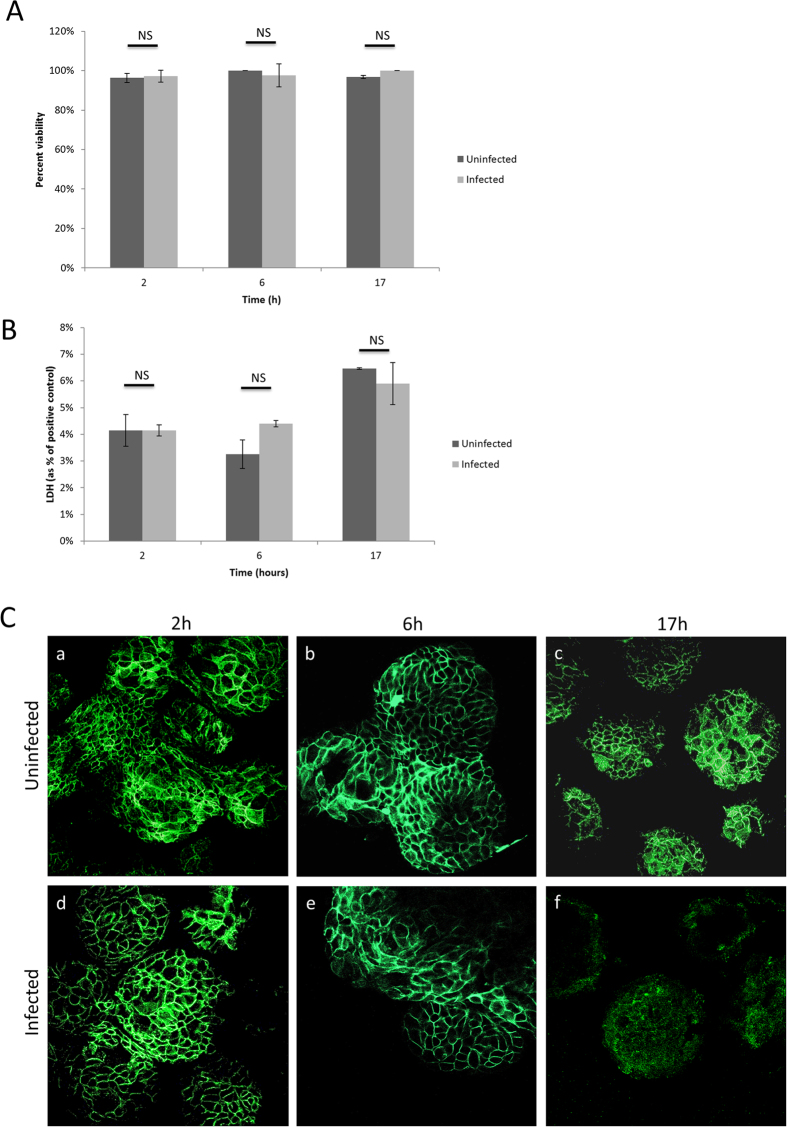
Effect of P. aeruginosa biofilms on host cell viability and tight junction formation in 3-D lung epithelial cells, following infection for 2 h, 6 h, and 17 h (as compared to uninfected controls): (A) Trypan blue exclusion assay. (B) LDH release assay. LDH release is presented as a percentage of a positive control (3-D lung epithelial cells lysed with Triton-X100). (C) Immunofluorescence imaging of the tight junctional marker β-catenin (green) for uninfected controls (a–c) and infected samples (d–f), at a magnification of 400x. NS = non-significant (p > 0.05).